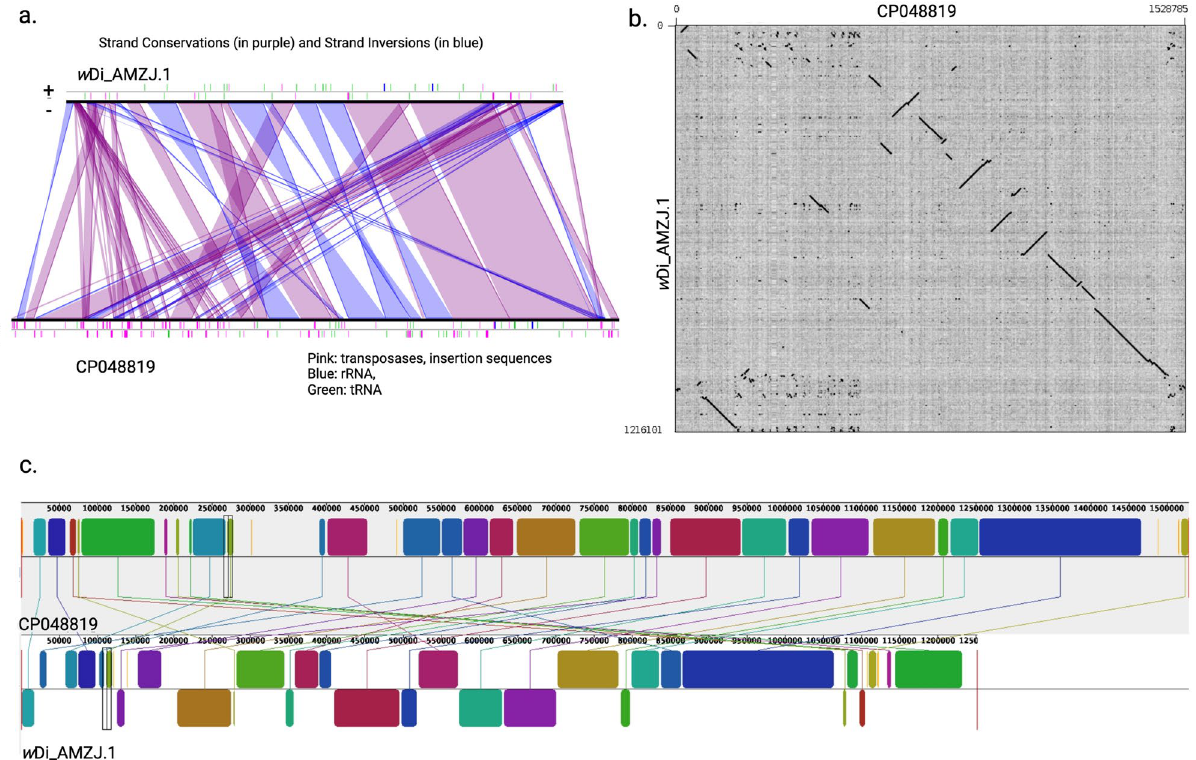
Figure 4. The comparison of complete w Di (CP048819) with draft w Di ( w Di_AMZJ.1). ( a ) Lineplot ( b ) Dotplot ( c ) Mauve alignment showing thirty local colinear blocks (LCBs) on the chromosomes that were identified and joined by connecting lines in the two genomes. Few LCBs in w Di_AMZJ.1 are inverted, which shows reverse complement orientation.